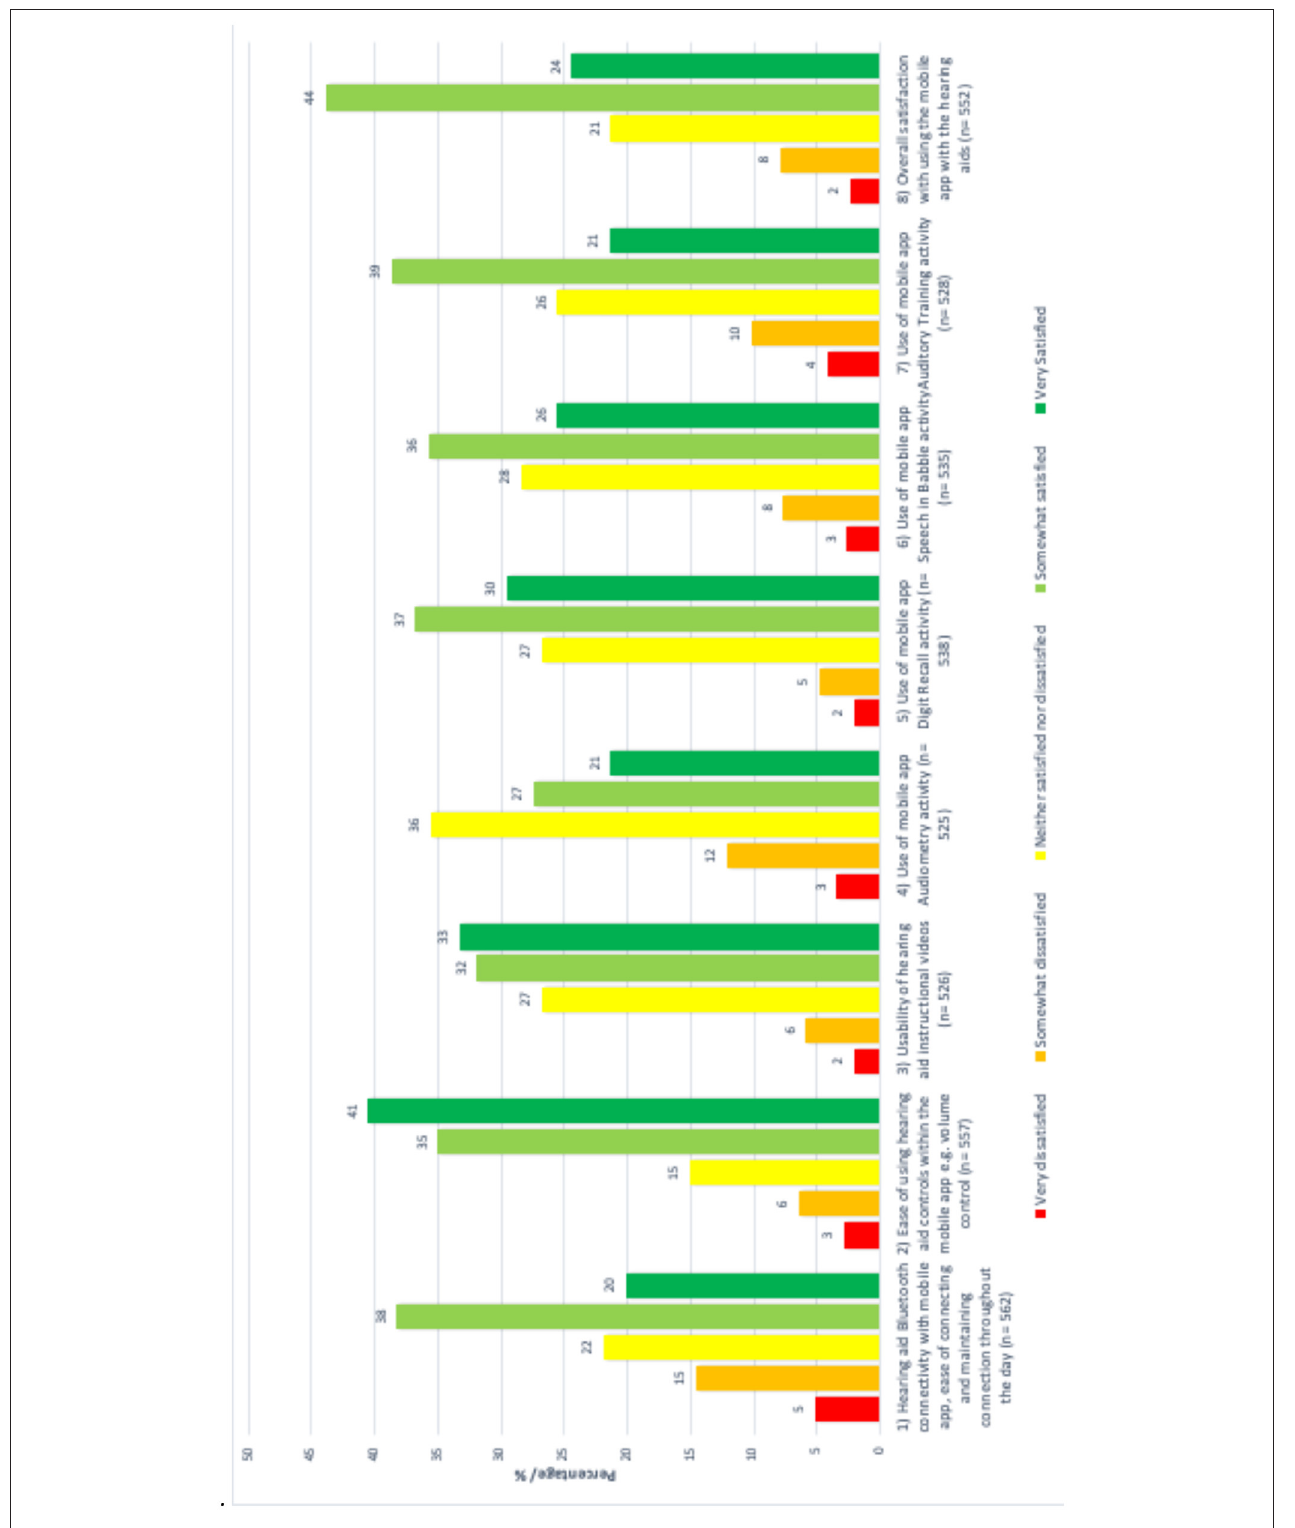
FIGURE 3 | Distribution of feedback